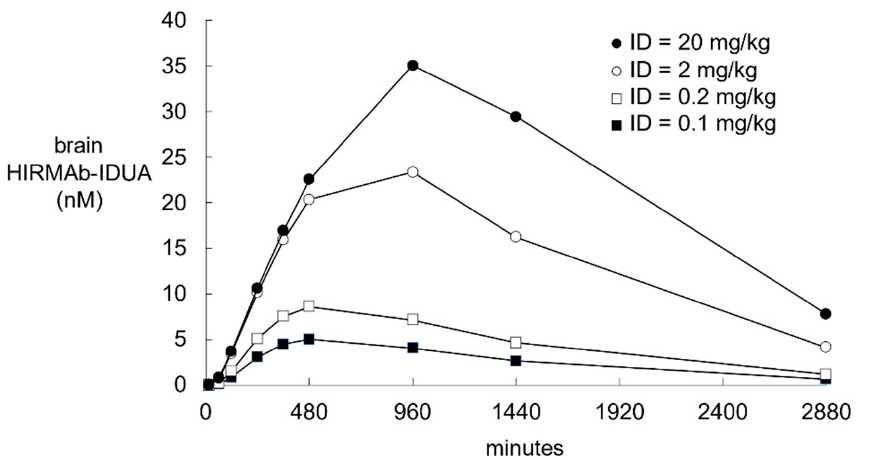
Figure 7. Predicted brain HIRMAb-IDUA fusion protein concentrations [variable F ( t ), Figure 5] are plotted from 0 to 2880 min after an IV administration of 0.1, 0.2, 2, or 20 mg/kg of the fusion protein in the monkey. The plasma input function, A ( t ), was computed from A 0 and α for each of these 4 injection doses reported previously [16,47]. The parameter values used for these simulations are those derived from simulation 15 (Figure 6, Table 8).